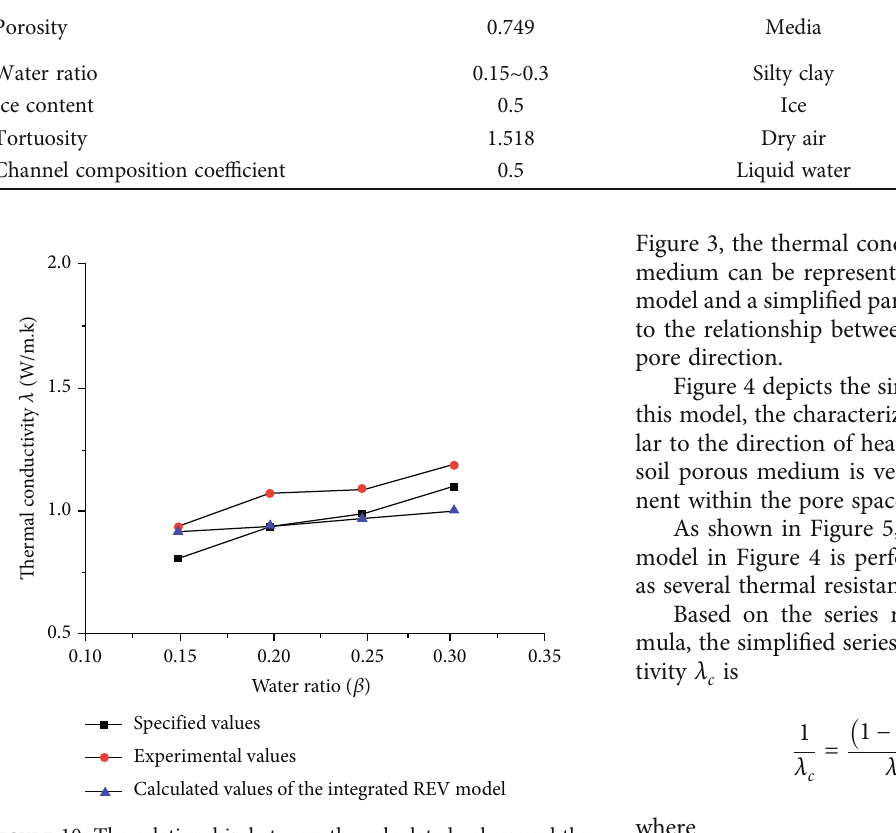
Figure 10: The relationship between the calculated values and the experimental and speci fi ed values of the integrated REV